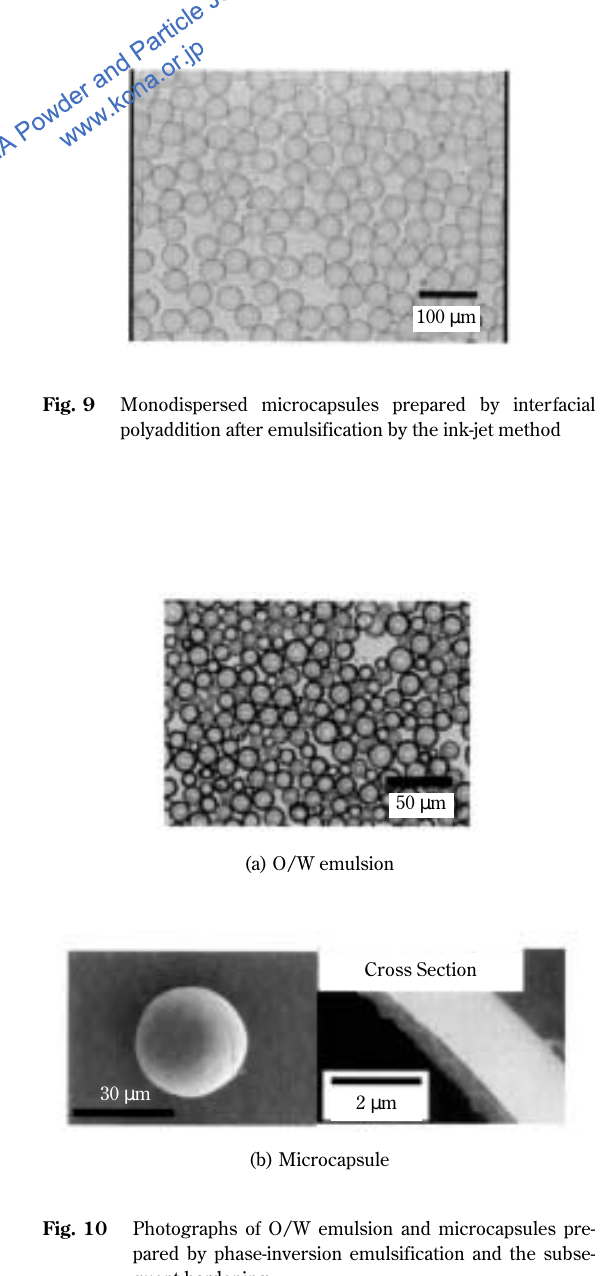
between isocyanate groups of the acrylic resin and diamine substances. As the figure shows, the pre- pared microcapsules were found to be monodispersed satisfactorily because emulsification using an ink-jet apparatus provided fairly evenly monodispersed oil droplets. Membrane thickness can be controlled in a range of up to 800 nm. Fig. 9 is an SEM photograph of microcapsules pre- pared by interfacial radical polymerization (interfacial in situ polymerization). In conventional in situ poly- merization, the polymerization reaction occurs in liq-